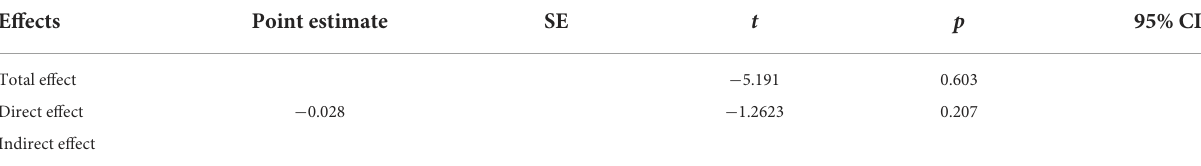
TABLE 3 Total direct and indirect effects of fear of COVID-19 on the number of vaccination injections attitudes through beliefs benefits of vaccination COVID-19.